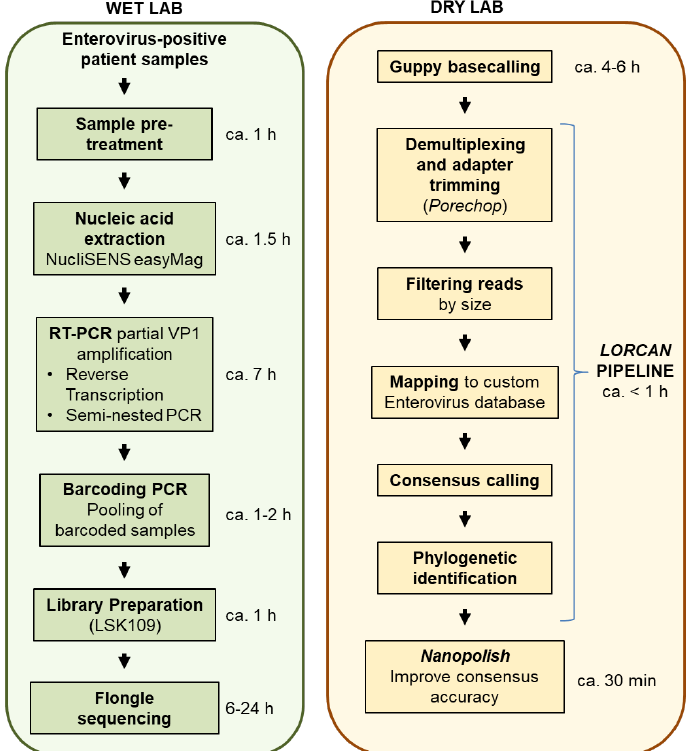
Figure 1. Flow chart of the main steps involved in enterovirus genotyping using Flongle flow cells. For each step, approximate time estimates are provided. The dry lab time estimations are based on using the LORCAN pipeline on a Linux server (2.4 GHz Intel Xeon E5 processors) and running Guppy 3.1.5 (high accuracy base-calling mode), LORCAN , and nanopolish with 16, 20, and 20 threads, respectively.